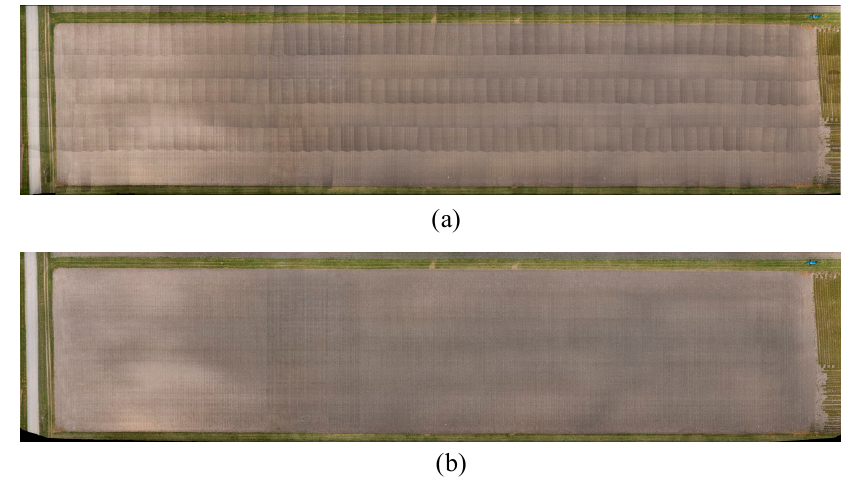
Figure 17. The generated RGB-based orthophoto mosaic from ( a ) the proposed automated aerial triangulation, and ( b ) Pix4D for S1000-Agriculture-1